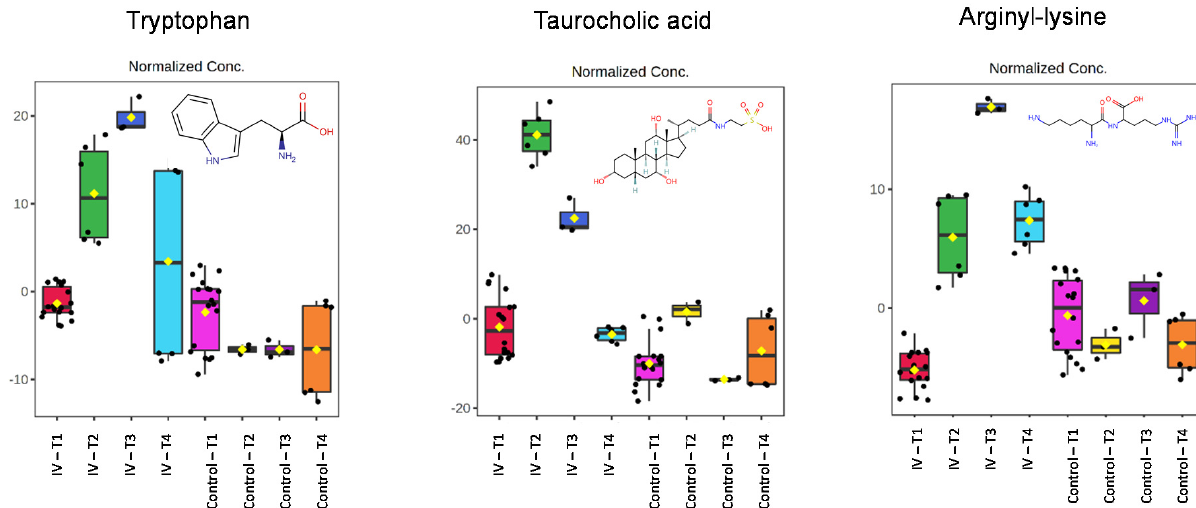
Figure 4. Pharmacometabodynamic variation in the urinary excretion of the endogenous metabolites of tryptophan, taurocholic acid, and arginyl-glycine (structures inset to Figure). The data for these metabolites were normalized using all features. The four time points are represented as pre-dose (T1, pink) and 0–3 h (T2, yellow), 3–8 h (T3, dark purple) and 8–24 h (T4, orange) post-dose for the control mice, and pre-dose (T1, red) and 0–3 h (T2, green), 3–8 h (T3, dark blue), and 8–24 h (T4, light blue) post-dose for gefitinib-dosed animals.